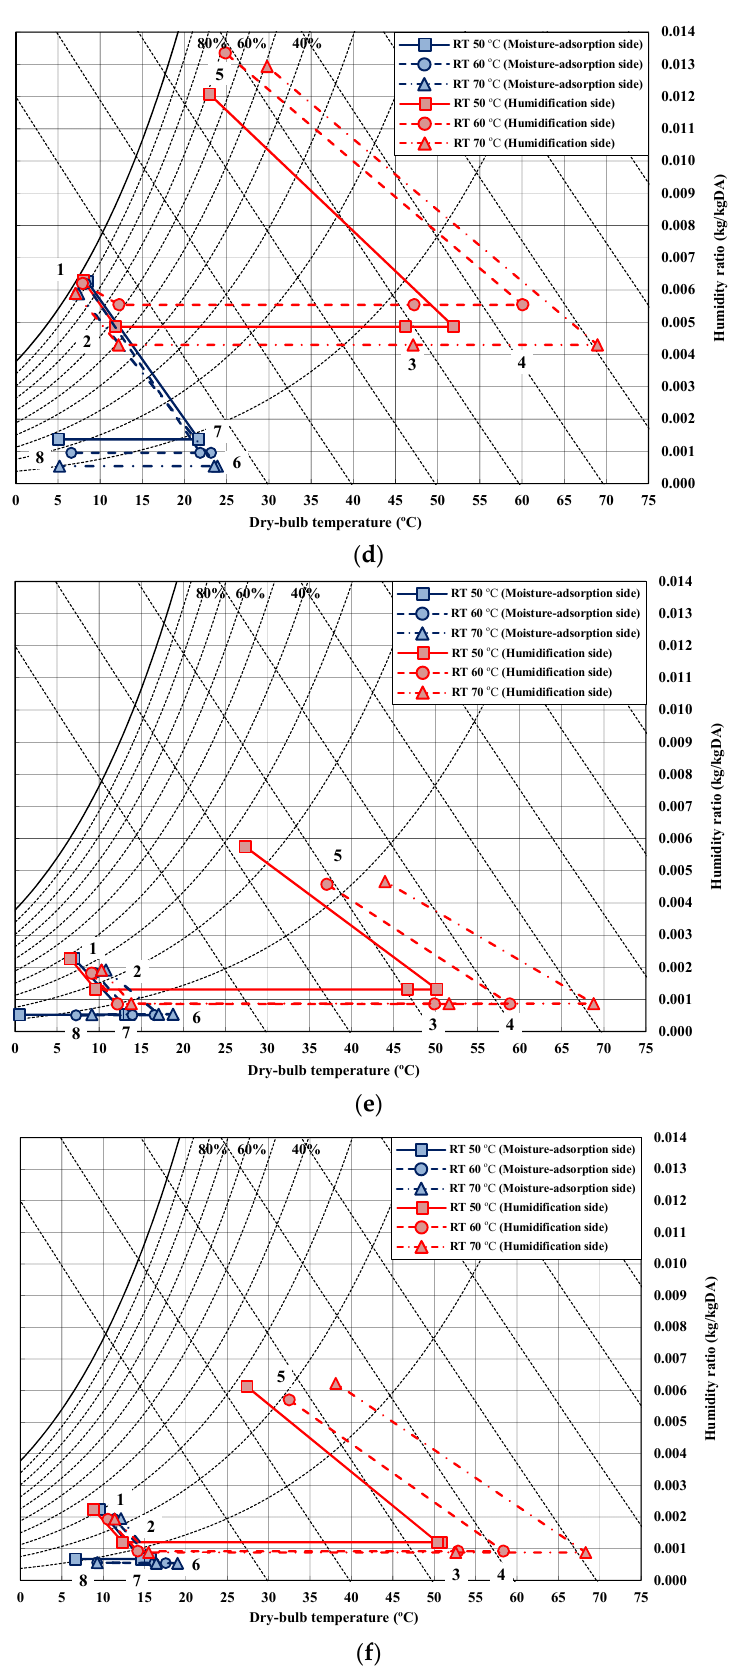
Figure 5. Plots of the experimental results on psychrometric charts for ( a ) Case A1; ( b ) Case A2; ( c ) Case B1; ( d ) Case B2; ( e ) Case C1; and ( f ) Case C2. RT = regeneration temperature.